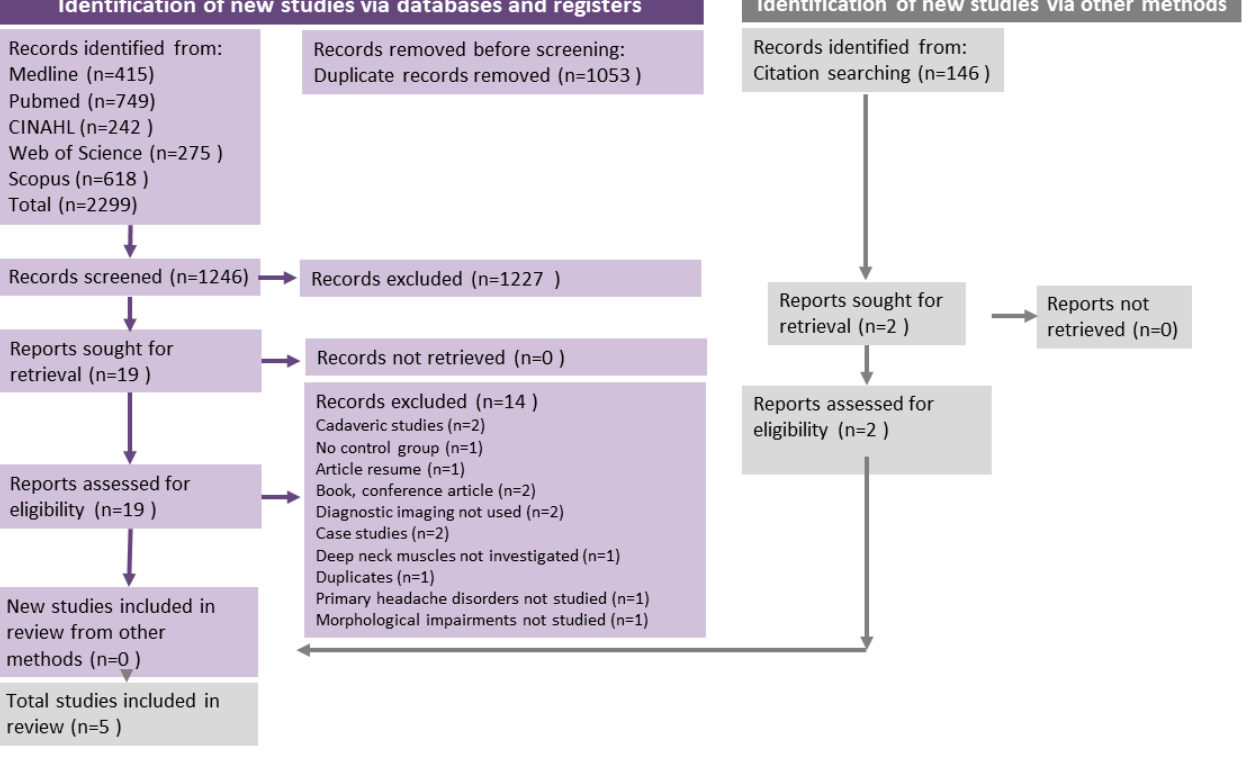
Figure 1. PRISMA Flow Chart. Flow chart of the studies included for this systematic review based on the PRISMA guidelines. The flow chart shows the articles that were found throughout the literature search of the five databases and the number of articles that were reviewed by title, abstract and full text.